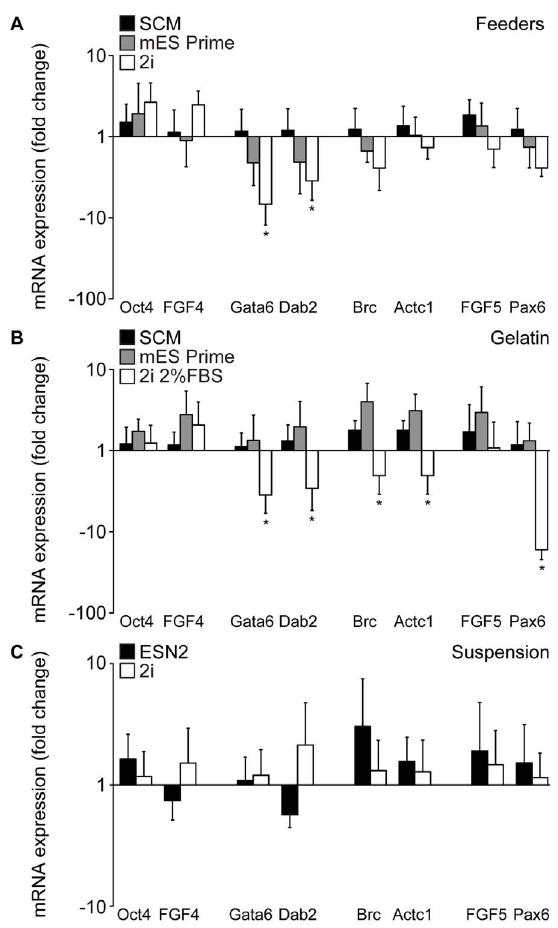
Figure 4. Analysis of ES cells cultured using different protocols as assessed by quantitative PCR. Quantitative PCR analysis at passage 15 for genes associated with undifferentiated mES cells, i.e. Oct4 and Fgf4, as well as early indicator genes for the three germ layers (endoderm: Dab2 and Gata6; ectoderm: Fgf5 and Pax6; mesoderm: Brc and Actc1). Graphs represent pooled results for mES cell lines grown on feeders (A) or on gelatin (B) in SCM, mES Prime Kit or 2i media, and in suspension (C) in 2i or ESN2 media. 18S expression is used for normalization, and results are comparative (SCM values for feeders and gelatin, and 2i media for suspension, were set as control) Ct value means 6 sd (n=3) p(*) , 0.05.